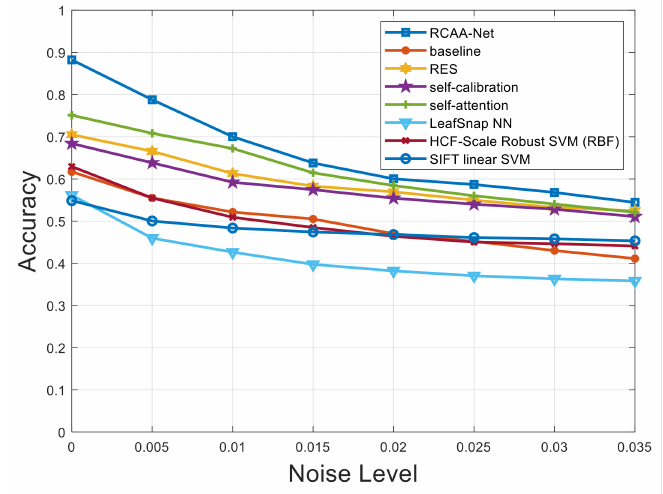
Figure 8. Recognition accuracy results when adding different levels of salt and pepper noise.